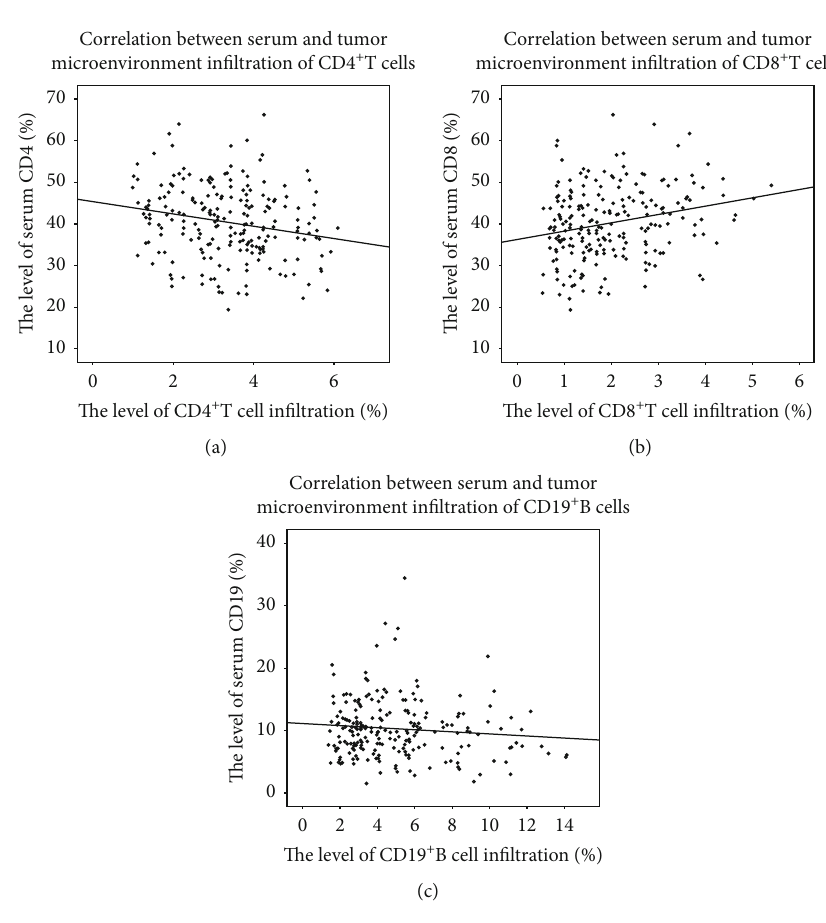
Figure 4: Correlations between serum CD4, CD8, and CD19 and in fi ltration of immune cells in the tumor